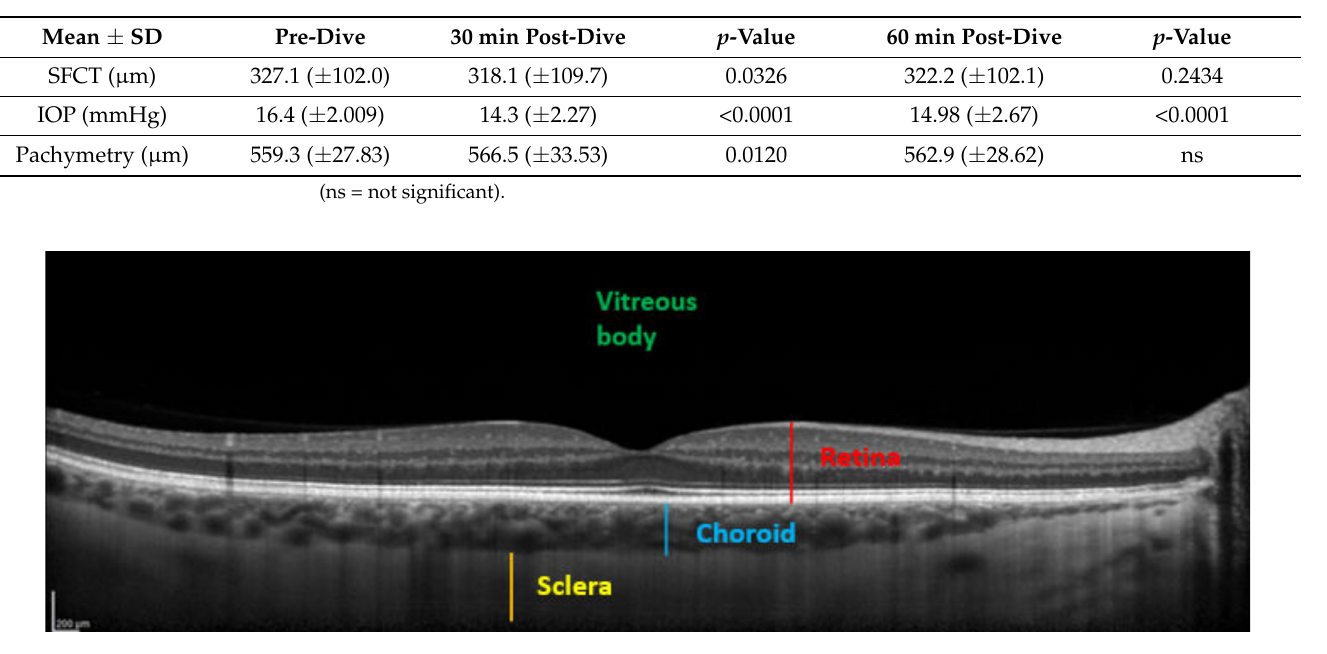
Figure 3. Enhanced depth imaging-optical coherence tomography (EDI-OCT) showing different structures. From anterior to posterior: Vitreous body (green), neurosensory retina and the retinal pigment epithelium (red), choroid (SFCT in blue), and sclera